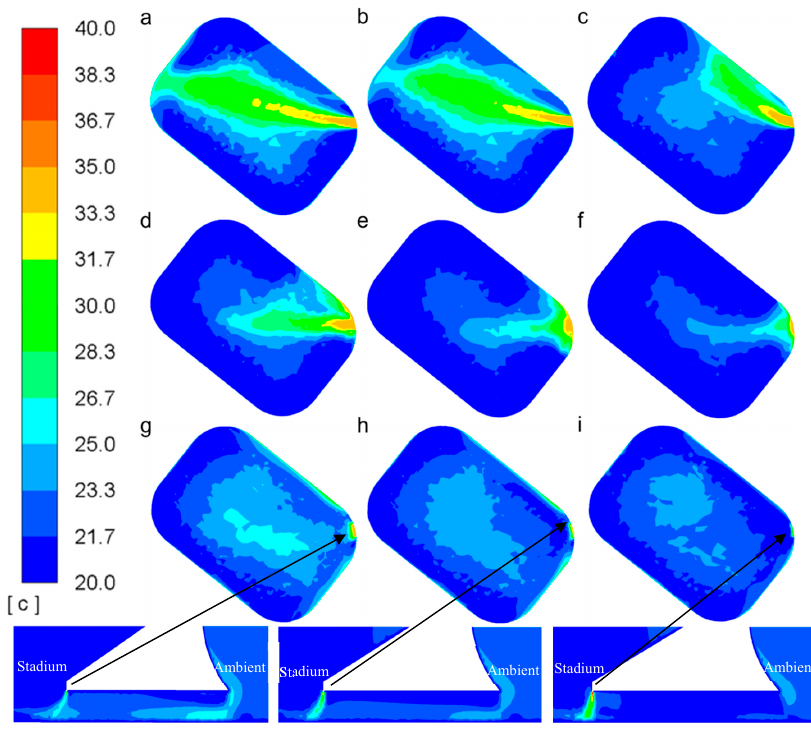
Figure 10. ( a – i ) Temperature distributions of the pitch (at height of 2.1 m) for scenarios 1–9. Table 6. Thermal comfort levels and estimated energy consumption per match for each